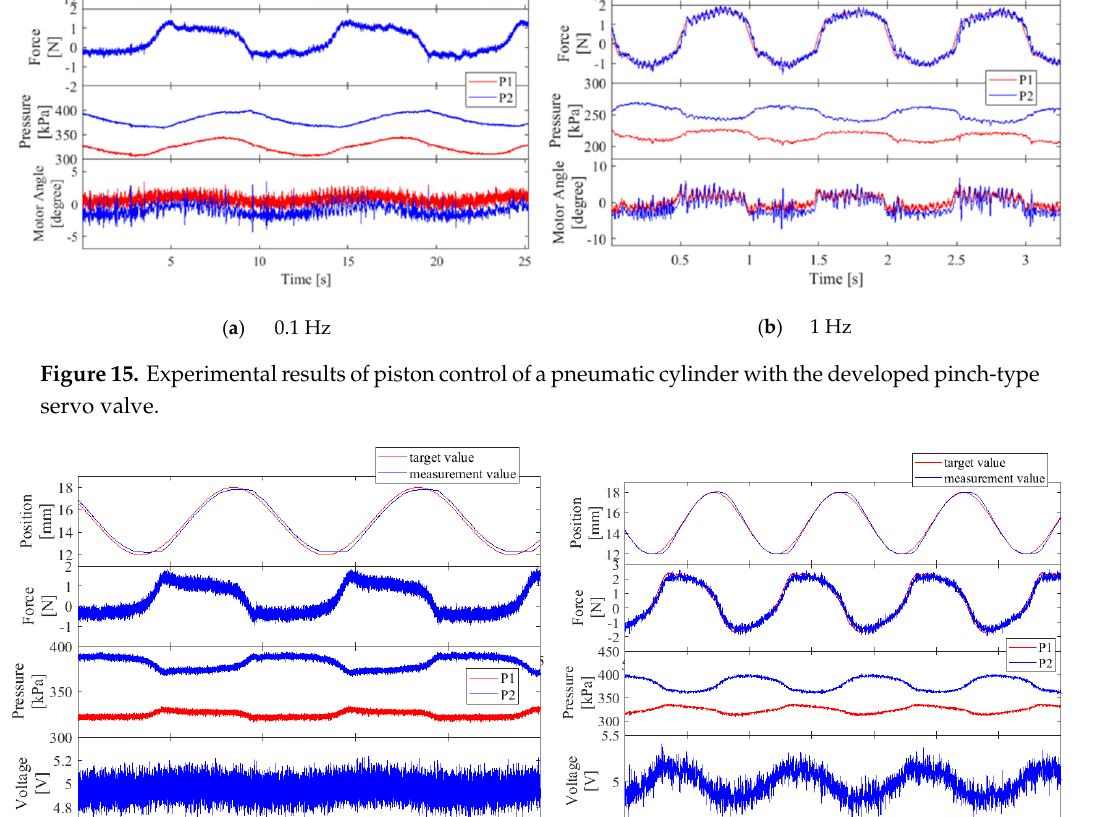
Figure 15. Experimental results of piston control of a pneumatic cylinder with the developed pinch- type servo valve.